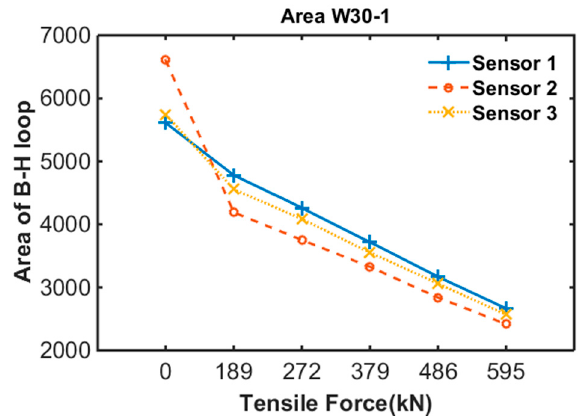
Figure 9 . B-H loop of specimen 1 . Figure 9. B-H loop of specimen 1.